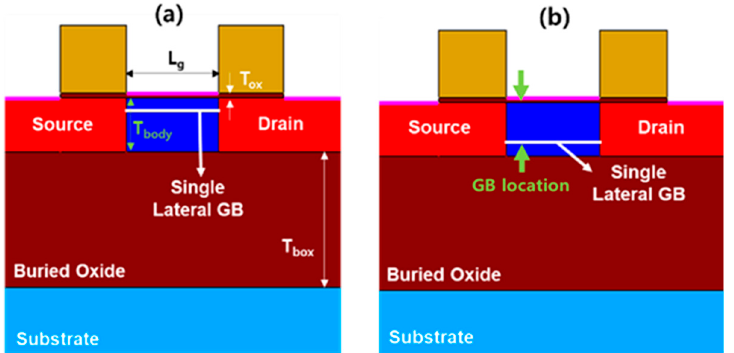
Figure 1. The simulated structure of poly ‐ Si one ‐ transistor one ‐ capacitor dynamic random ‐ access memory (1T ‐ DRAM) cell with two lateral grain boundary (GB) locations. The lateral GB distances from the SiO 2 /poly ‐ Si interface are depicted as ( a ) 10 nm and ( b ) 30 nm.